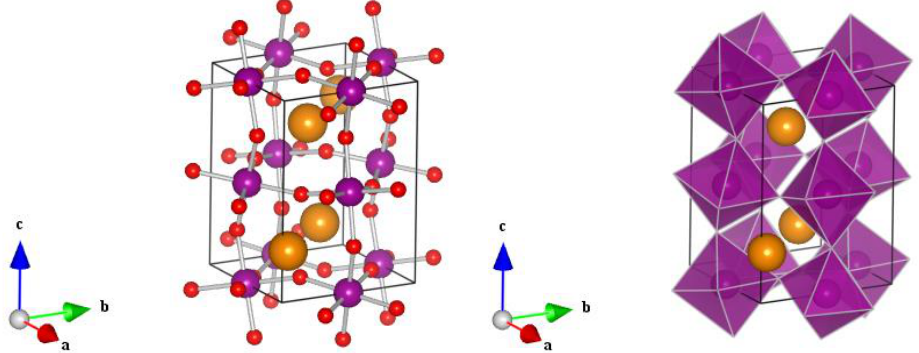
Figure 3. Crystallographic structure of NdMnO 3 . Purple, orange and red-colored balls represent the Mn, Nd and O, respectively.